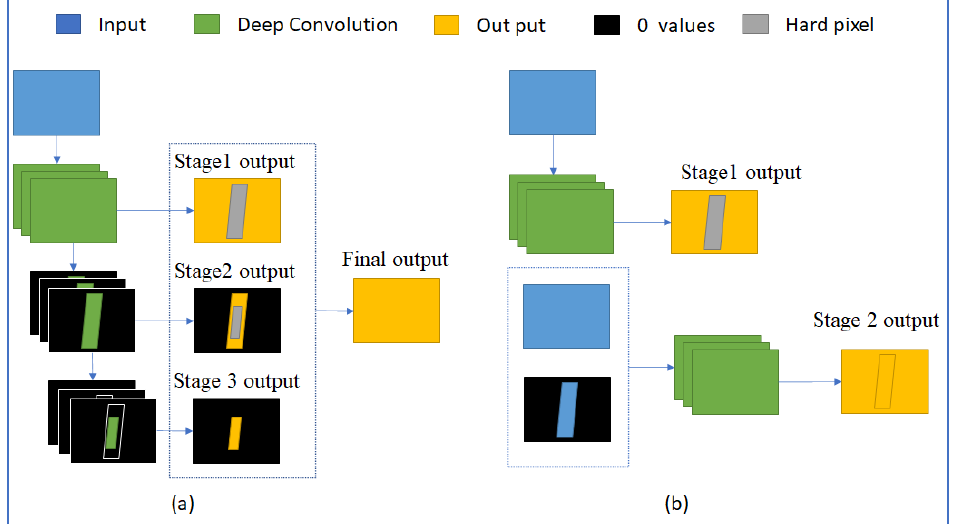
Figure 5. ( a ) is the deep LC structure, and ( b ) is our proposed multi-stage structure. The yellow region is the final output. The grey region is a hard region that is detected by comparing the pixel score of output to a threshold. The black region is the removed region of pixels having 0 value.